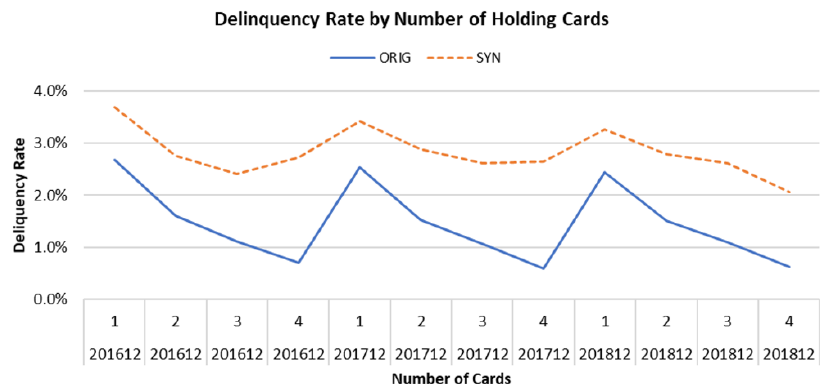
Figure 8. The delinquency rate by the credit card holding period in months at the end of the years from 2016 to 2018.